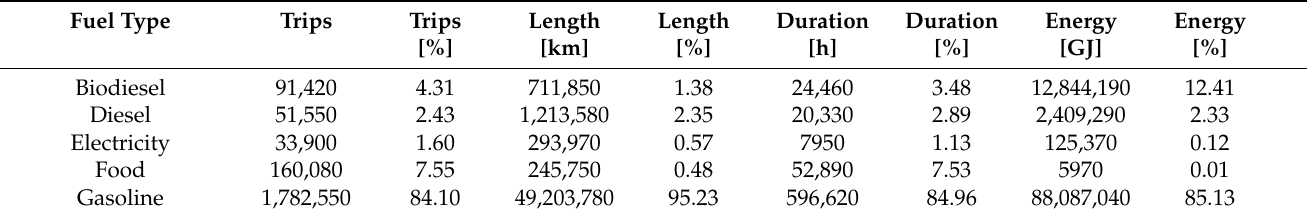
Table 4. Statistics of trips involving Santa Clara County in the developing scenario by fuel type— interfered to the